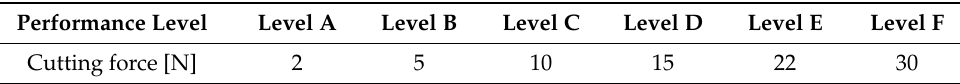
Table 2. Performance levels for cut resistance [3].